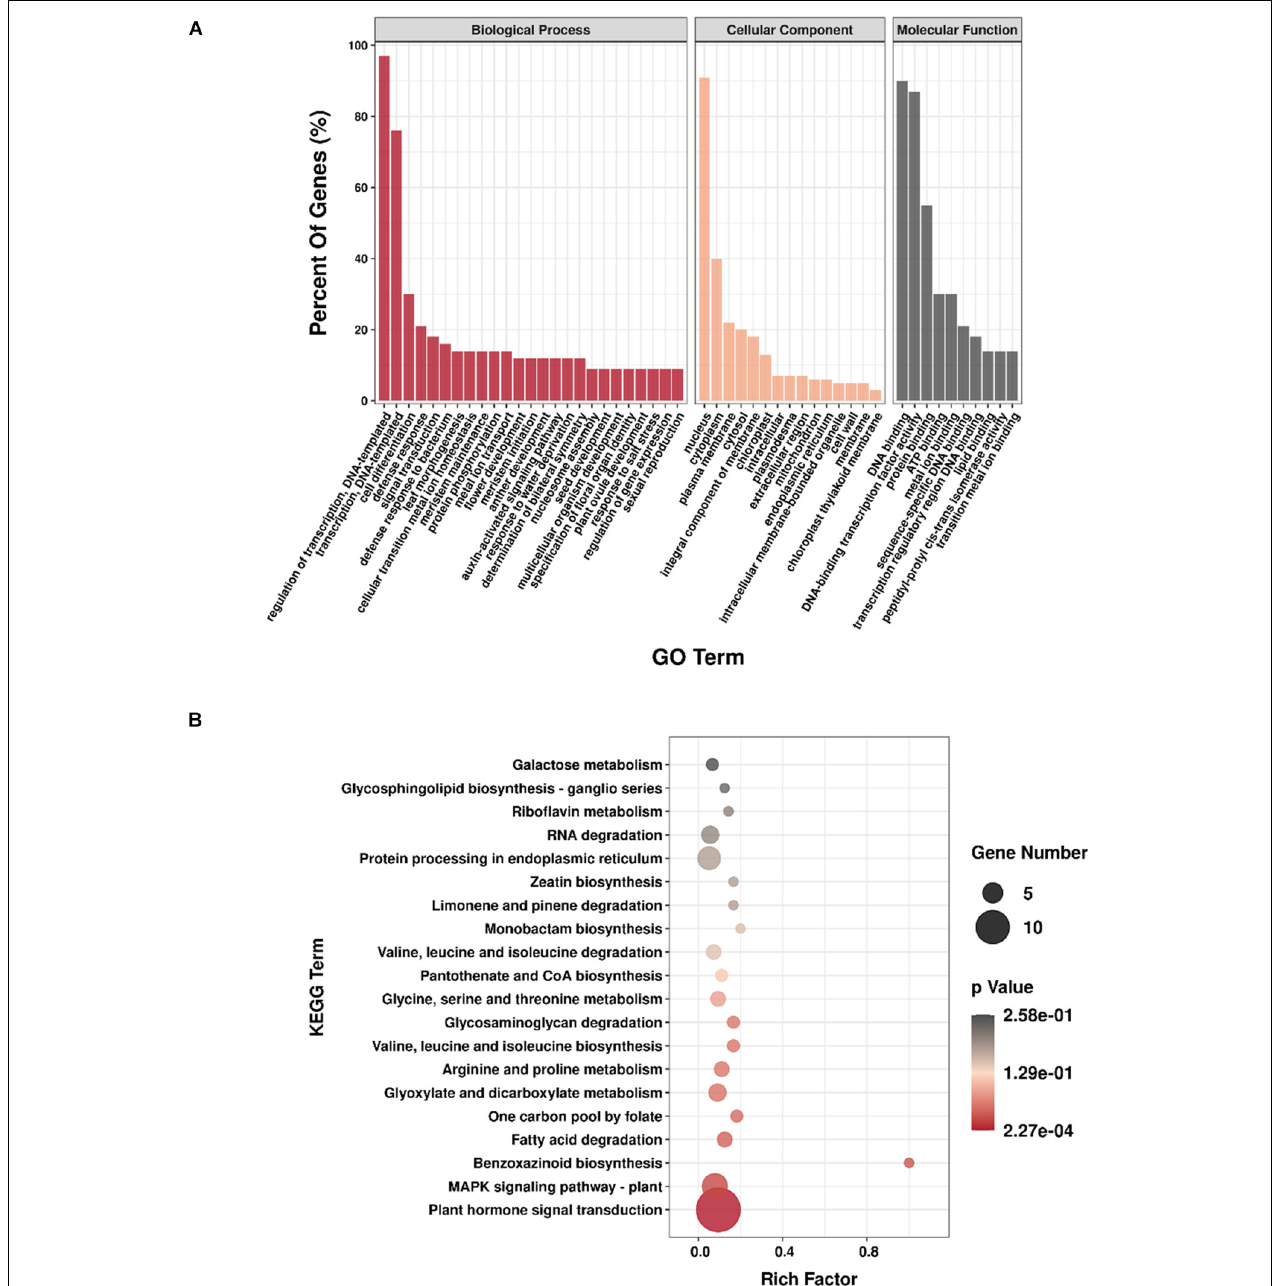
FIGURE 4 | Enrichment analysis of target genes. (A) GO annotation of the genes targeted by miRNAs; (B) KEGG enrichment of genes targeted by miRNAs.